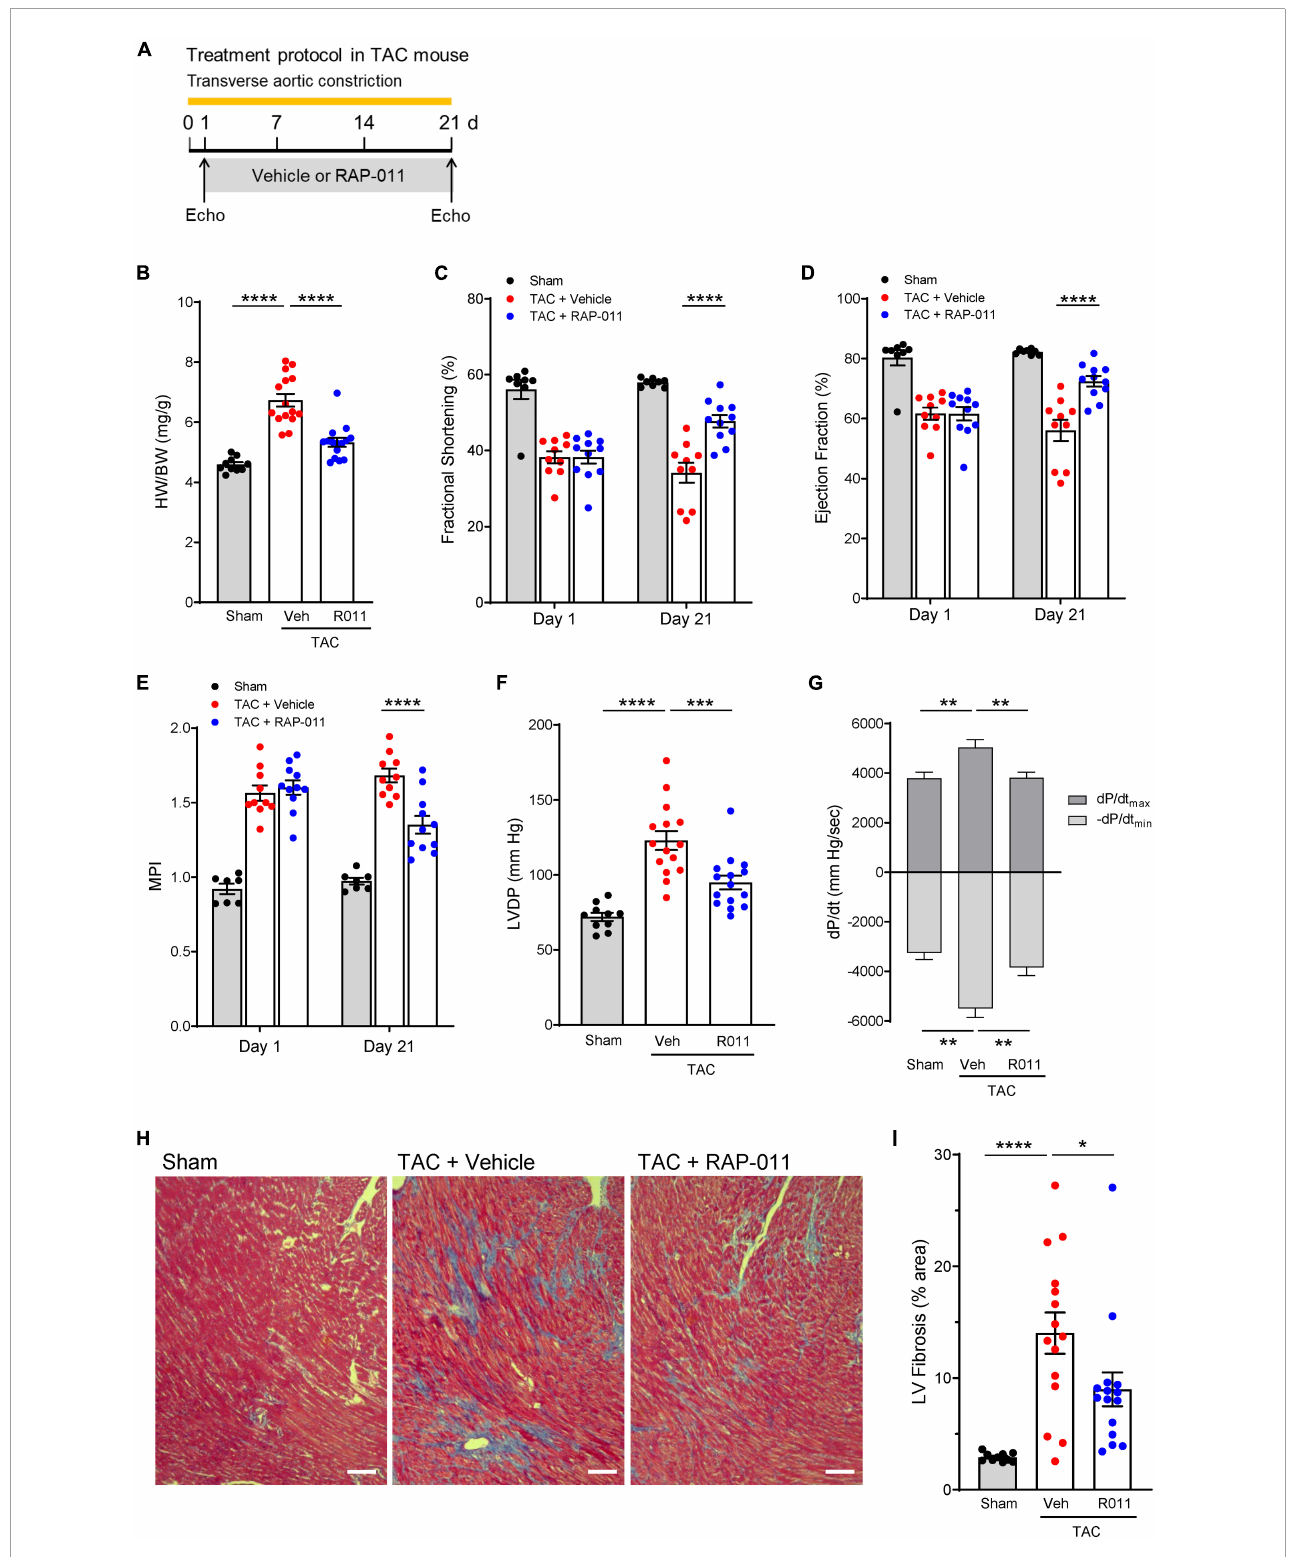
FIGURE1 ActRIIA-Fc exerts structural, functional, and anti-fibrotic cardioprotective effects in a transverse aortic constriction (TAC) mouse model of left heart failure caused by sustained pressure overload. (A) Experimental approach used to assess effects of ActRIIA-Fc (RAP-011). Wild-type mice were subjected to TAC and treated twice weekly with RAP-011 (R011, 10 mg/kg, s.c.) or vehicle (veh, phosphate-buffered saline, PBS) for 3 weeks starting one day post-surgery. (B) Heart weight normalized to body weight (HW/BW), (C) fractional shortening, (D) ejection fraction, (E) myocardial performance index (MPI), (F) LV developed pressure (LVDP), and (G) peak rates of LV pressure rise (dP/dt max ) and decline (-dP/dt min ). Data are means ± SEM ( n = 10–15 mice per group for day 21). (H) Representative images of LV sections stained with Masson’s trichrome blue to detect fibrosis (scale bar, 100 µ m), and (I) quantification of percentage area occupied by fibrotic tissue. Data are means ± SEM ( n = 10–15 mice per group). Analysis by one-way ANOVA and Dunnett’s post-hoc test (* P < 0.05, ** P < 0.01, *** P < 0.001, **** P <